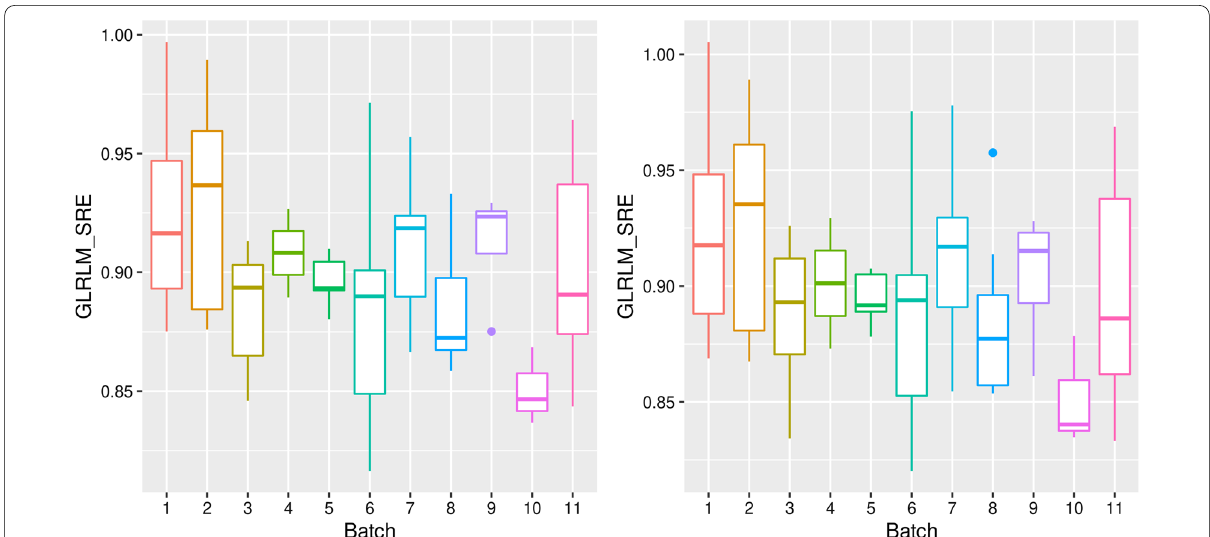
Fig. 3 An example of feature harmonization for a sample feature, GLRLM SRE. On the left is the box-plot for the feature distribution across batches (defined as protocols) before longComBat harmonization, and on the right is the Box-plot after the